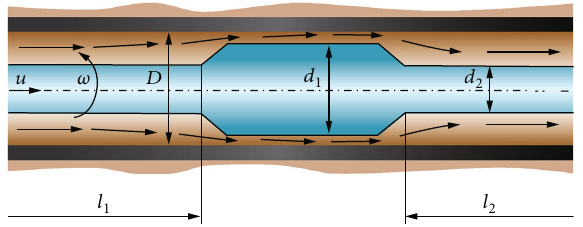
Figure 2: Geometry of the fl ow fi eld outside the drillstring